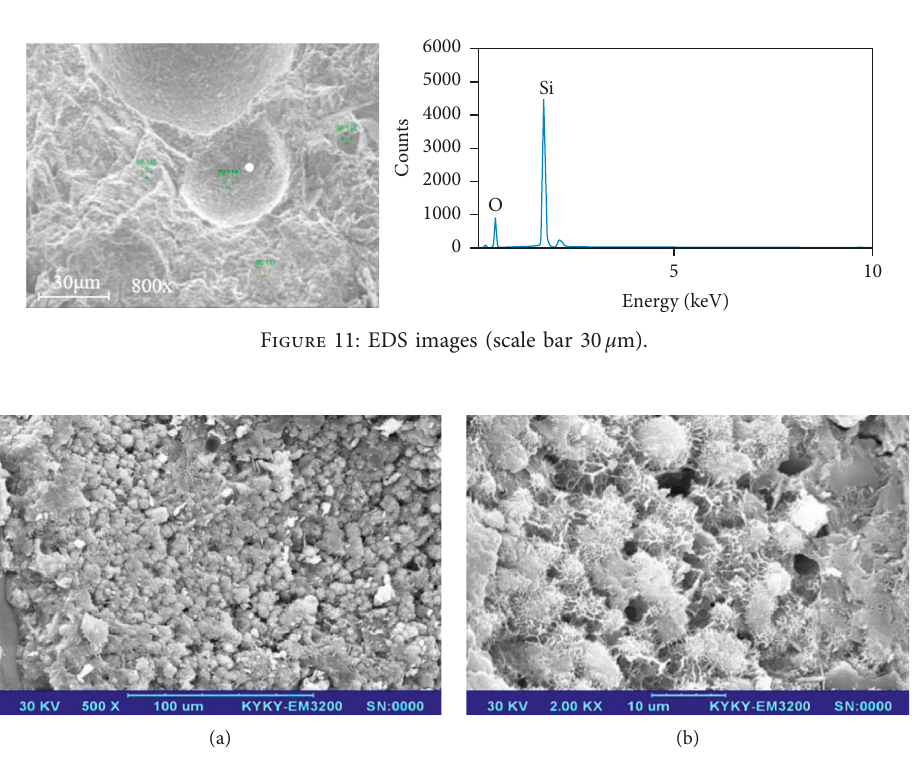
Figure 12: Microstructures of 40% FA: (a) 500 × and (b) 2,000 ×